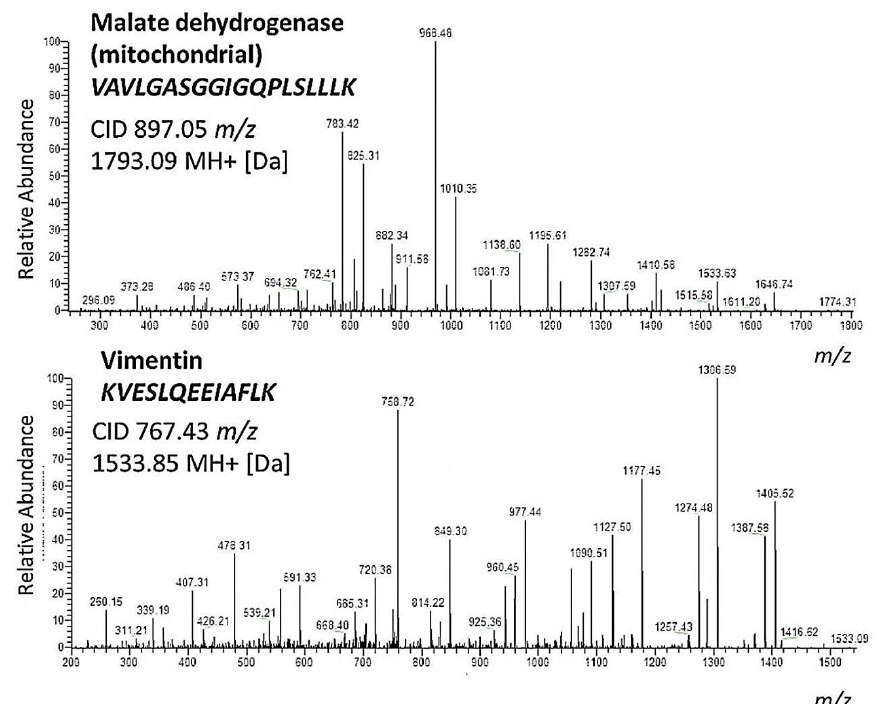
Figure 4. Exemplary BULCMS corresponding MS / MS fragmentation spectra leading to the identification of mitochondrial malate dehydrogenase (Gene name: MDH2 ), displaying RET-specific abundance, and vimentin (Gene name: VIM ), showing ONH-specific abundance. The identification was based on MS / MS-spectra of the MDH2-specific peak at m / z 897.05 with the sequence VAVLGASGGIGQPLSLLLK and on tandem MS spectra of the VIM-specific peak at m / z 767.43 with the sequence KVESLQEEIAFLK .